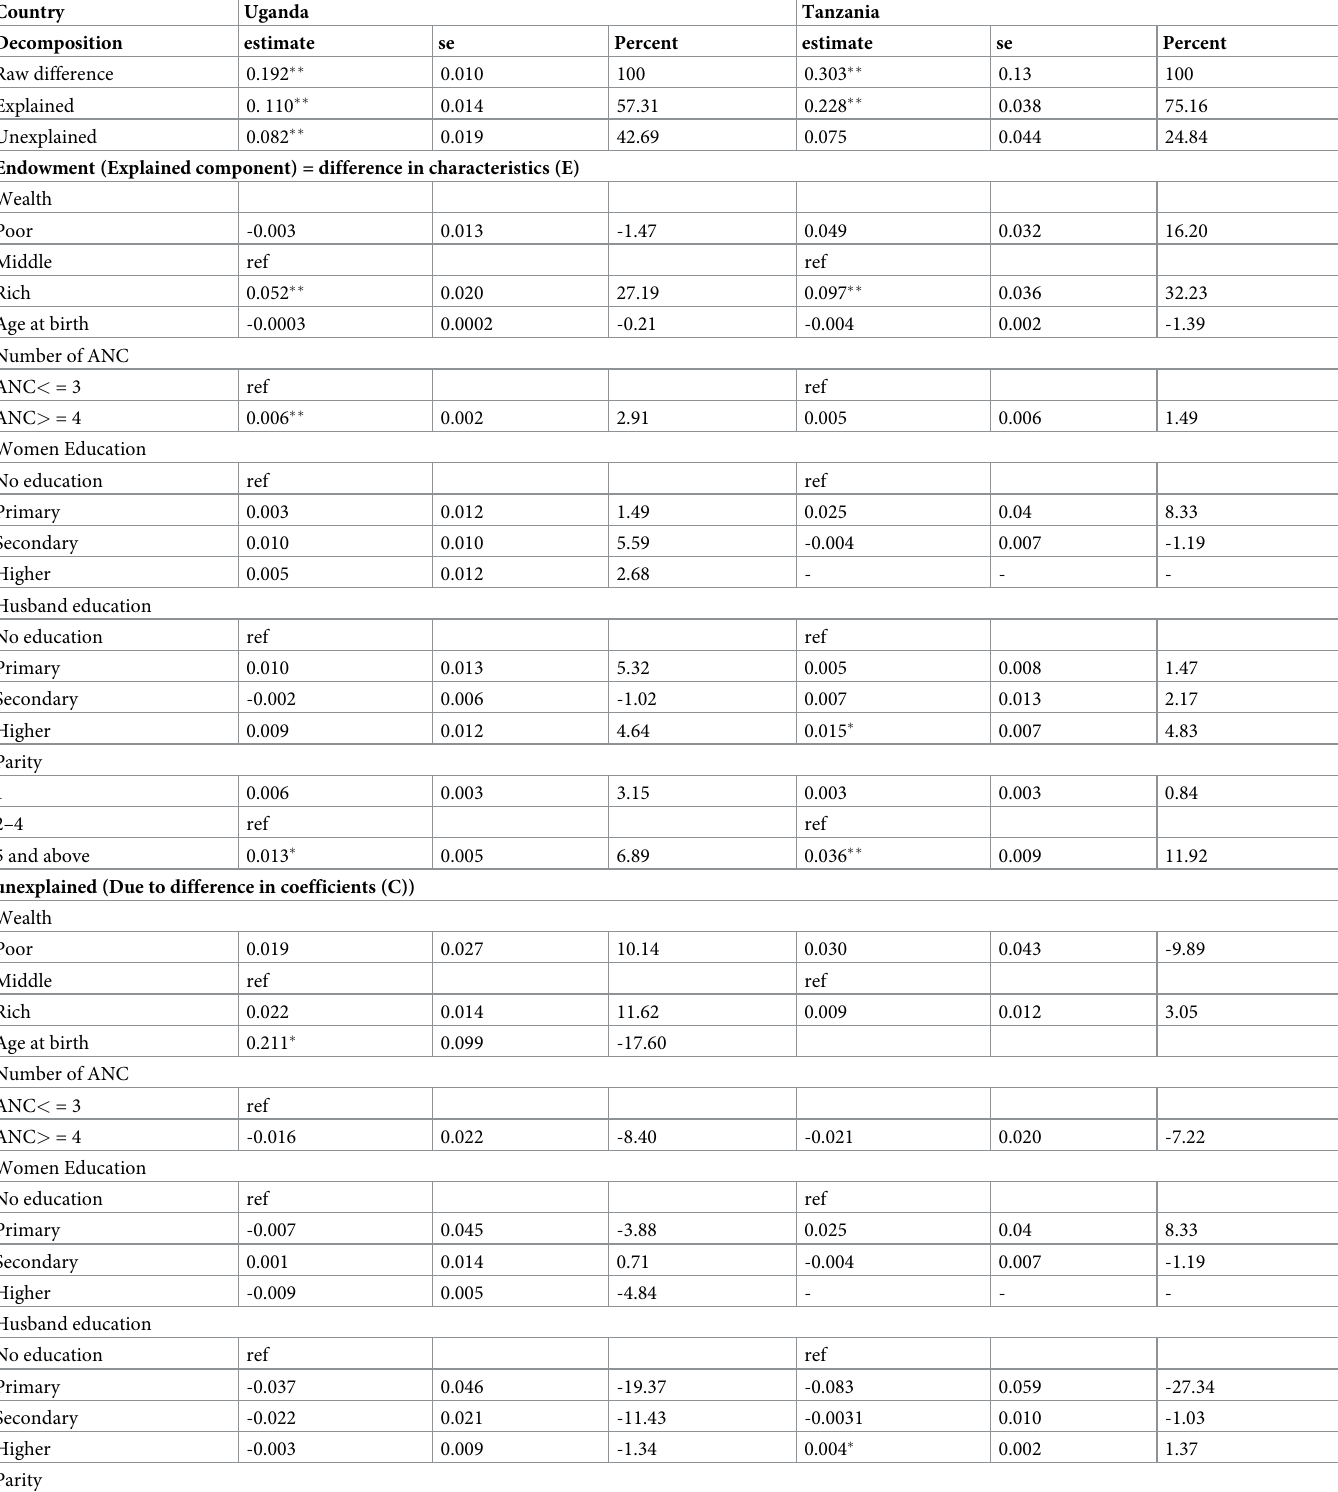
Table 4. Detailed decomposition of institutional delivery by place of residence for Ugandan and Tanzanian women. Country Uganda